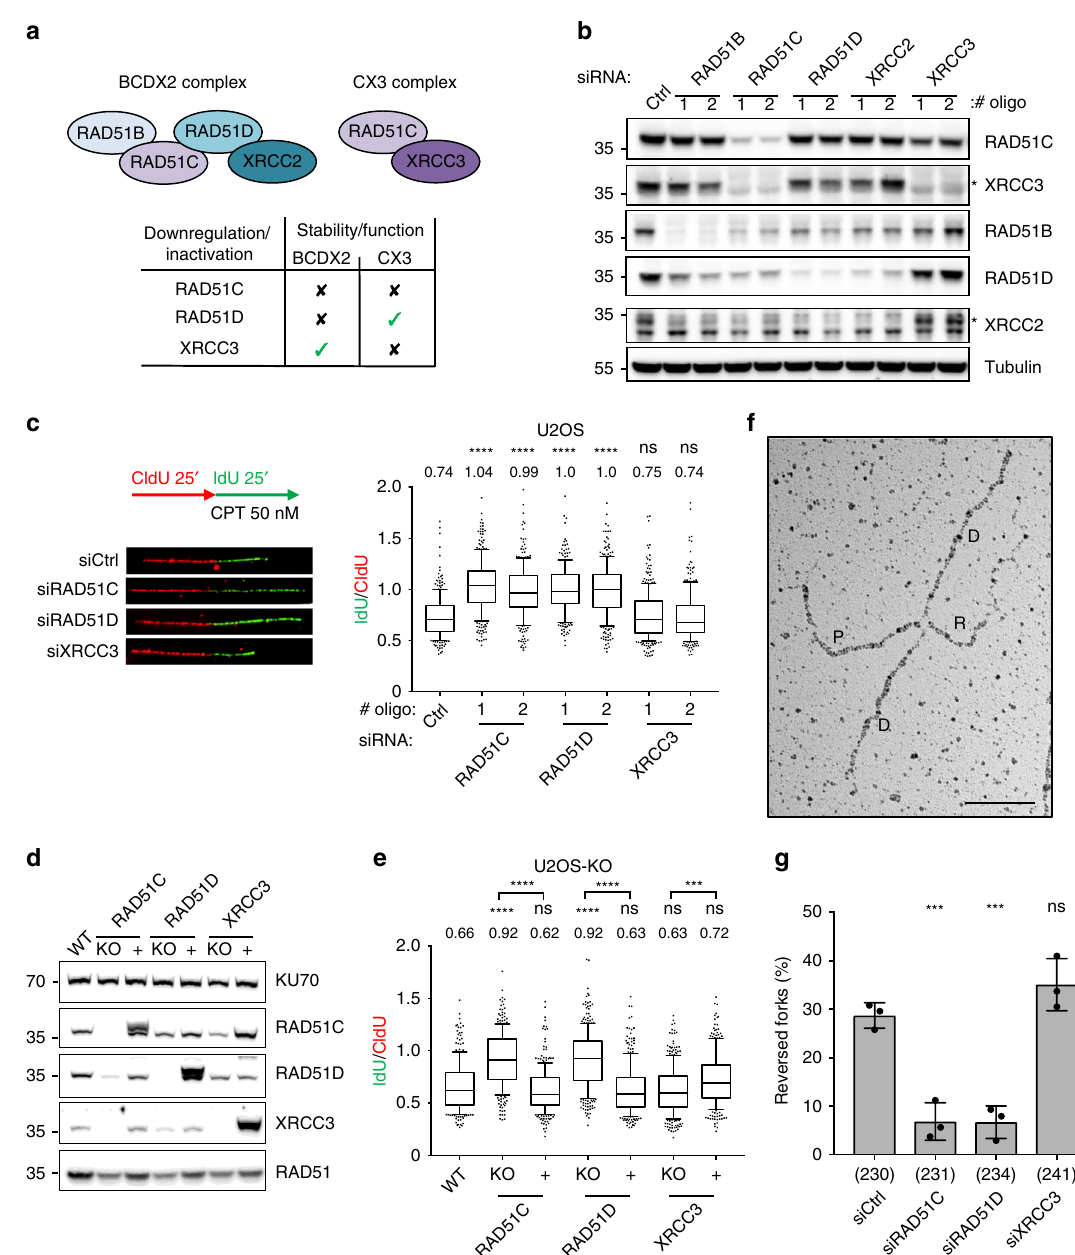
Fig. 2 BCDX2 paralog complex, but not CX3, promotes replication fork slowing and reversal upon mild CPT treatment. a Rationale for focusing on RAD51C , RAD51D , and XRCC3 downregulation, to perform functional studies on BCDX2 and CX3 complexes during replication stress. Top: schematic of the two main RAD51 paralog complexes. Bottom: differential effects of RAD51C , RAD51D , and XRCC3 inactivation on paralog complex stability/function. b Western blot analysis of RAD51 paralogs upon 48 h downregulation with two different siRNAs. Ctrl, control siRNA; Tubulin, loading control. asterisk, speci fi c band. In b and d multiple gels/blots were processed in parallel, ensuring equal and comparable loading across gels. The experiment was performed twice yielding similar results. c DNA fi ber analysis of U2OS cells 48 h after transfection with a control siRNA (siCtrl) or with siRNAs targeting RAD51C , RAD51D , and XRCC3 . Top-left: schematic of the CldU/IdU pulse-labeling protocol used to evaluate fork progression upon 50 nM CPT treatment. Bottom- left: representative DNA fi bers from each genetic condition. Left: IdU/CIdU ratio is plotted as a readout of fork progression. In c and e , the numbers indicate the mean value; a minimum of 150 forks was scored in two independent experiments yielding similar results. Bounds of box are 25 – 75th percentile, center shows the median, whiskers indicate the 10 – 90 percentiles, data points outside this range are drawn as individual dots. Statistical analysis: Kruskal – Wallis test; ns not signi fi cant; **** p -value < 0.0001, *** p -value = 0.0003. d Western blot analysis of RAD51 paralogs in Knock-Out (KO) U2OS cells and in cells reconstituted of the respective protein ( + ). KU70, loading control. The experiment was performed twice yielding similar results. e DNA fi ber analysis of KO and reconstituted ( + ) U2OS cells labeled as in c . f , g Frequency of reversed replication forks in U2OS cells transfected with control siRNA (Ctrl) or with siRNAs targeting RAD51C , RAD51D , or XRCC3 for 48 h and treated with 50 nM CPT (1 h). f Electron micrograph of a representative reversed replication fork from CPT-treated U2OS cells (P parental duplex, D daughter duplexes, R regressed arm; scale-bar, 100 nm). g Graph-bar showing mean and SD from three independent EM experiments. In brackets, total number of molecules analyzed per condition. Statistical analysis: one-way ANOVA followed by Bonferroni test; ns not signi fi cant; *** p -value = 0.0004. Source data for b – g are provided in the Source Data fi